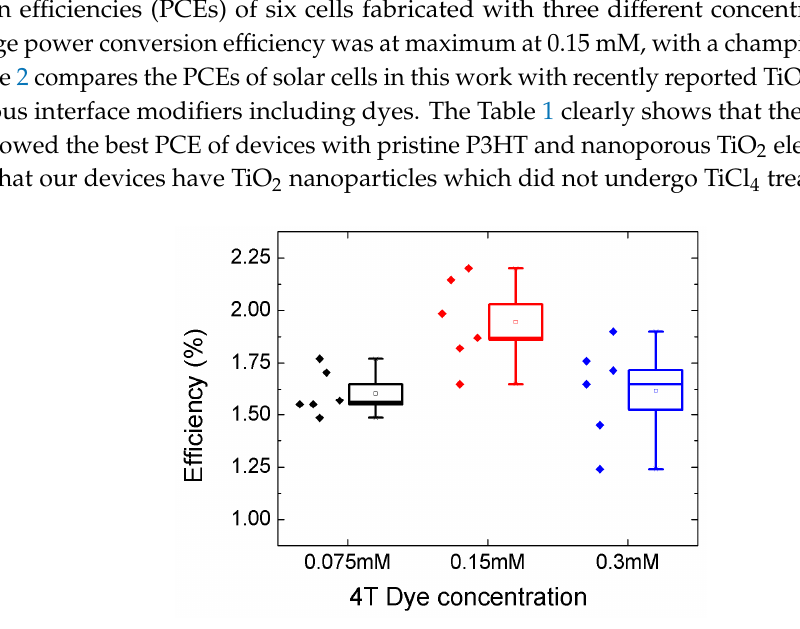
Figure 7. Distribution of power conversion efficiencies of six cells fabricated with three different concentrations (box indicates the standard deviations, whiskers indicate the range, and the small square in the middle of each box indicates the average). Table 2. Photon conversion efficiencies (PCEs) of recently reported TiO 2 /P3HT solar cells with various interface modifiers including dyes.